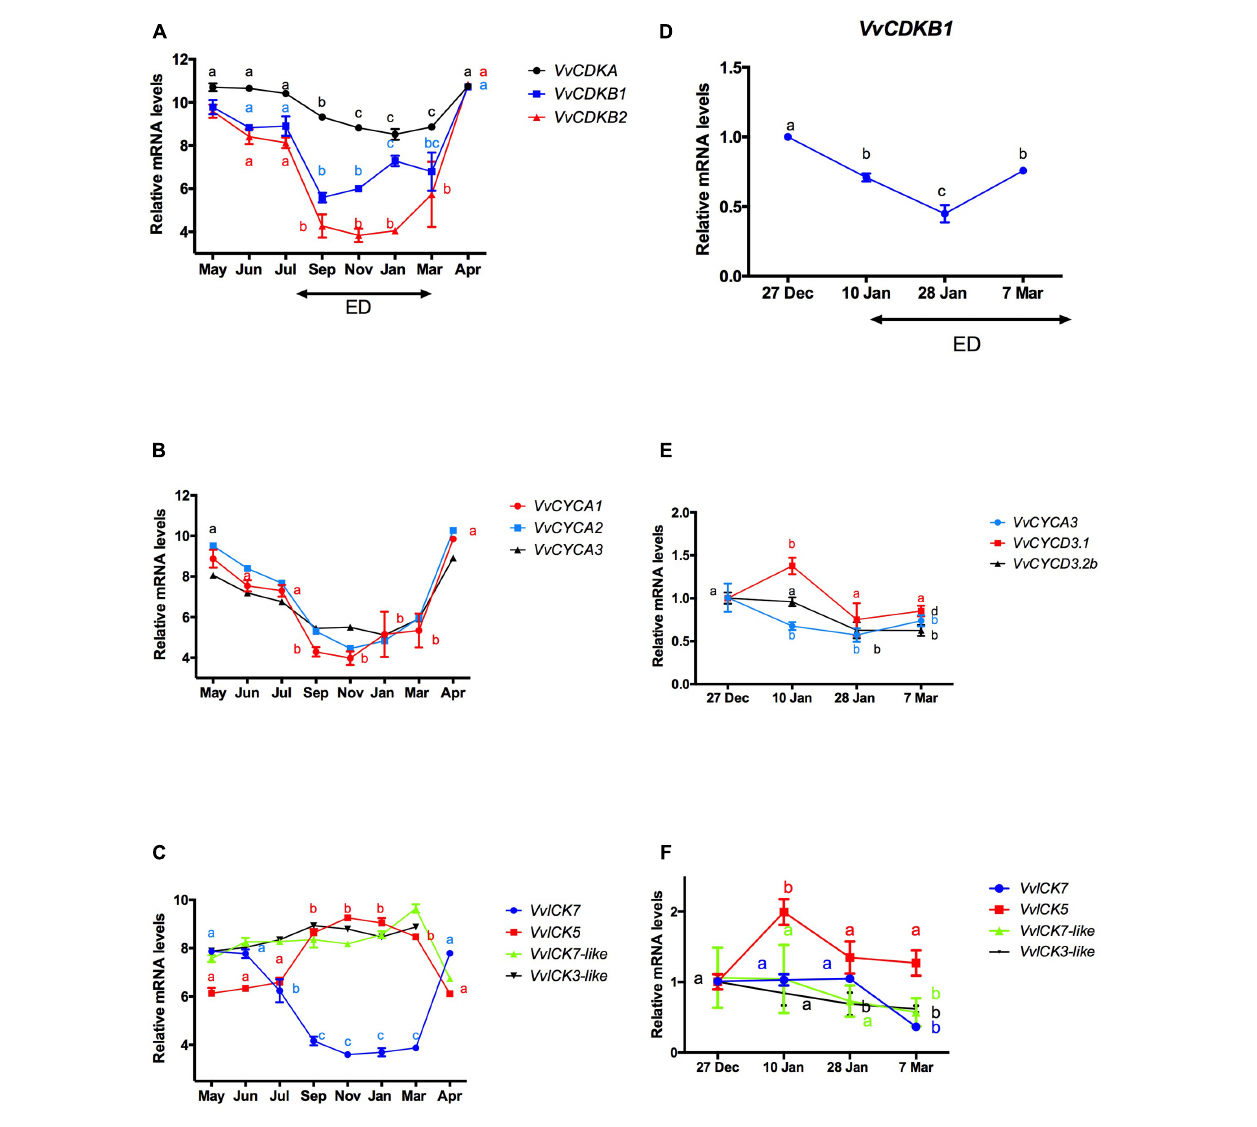
FIGURE 4 | Changes in the expression of (A) cyclin-dependent kinases ( VvCDKs ), (B) cyclins ( VvCYCs ), and (C) inhibitors of CDKs ( VvICKs ) during the development of endodormancy (ED) in Tempranillo grapevine buds grown at the Northern Hemisphere and in Thompson seedless grapevine buds grown in the Southern Hemisphere (D–F) . Values for Tempranillo grapevine buds were taken from (Díaz-Riquelme et al., 2012), and those for Thompson seedless were determined by RT-qPCR and normalized against VvUBIQUITIN . Values for Tempranillo and Thompson seedless are the average of three biological replicates with three technical repetitions ± SD. Different lower case letters represent significant differences between transcript collected from grapevine buds at different times Tukey’s test ( α =